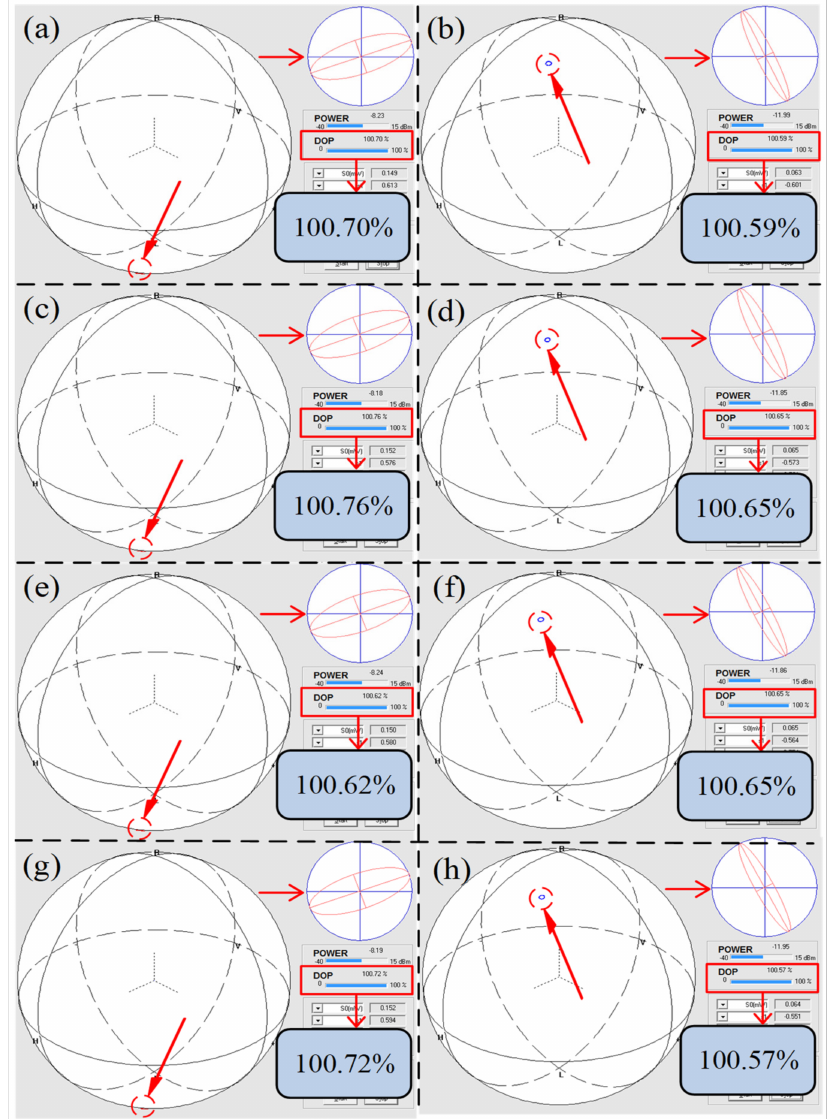
Figure 9. Measurements of the SOPs in single-wavelength lasing operations at ( a ) λ 1, ( b ) λ 2, ( c ) λ 3,